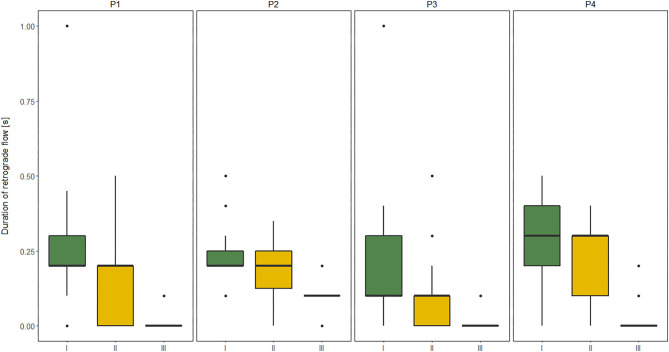
Comparisons between subgroup: I, II, and III level of Gross Motor Function Classification System (GMFCS) in relation to the duration of retrograde flow (RT) evaluated at four sites of Great saphenous vein (GSV): proximal thigh level (P1); medial thigh level (P2); upper leg level (P3); lower leg level (P4) of lower limbs (n = 60 each) measured in vertical position in children with myelomeningocele (MMC group). Kruskal–Wallis test for independent samples.